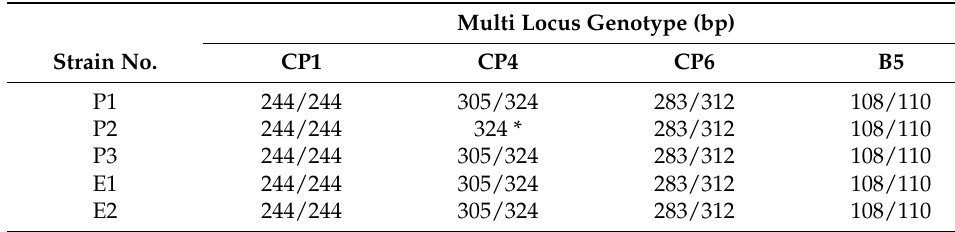
Table 3. Microsatellite fragment analysis.